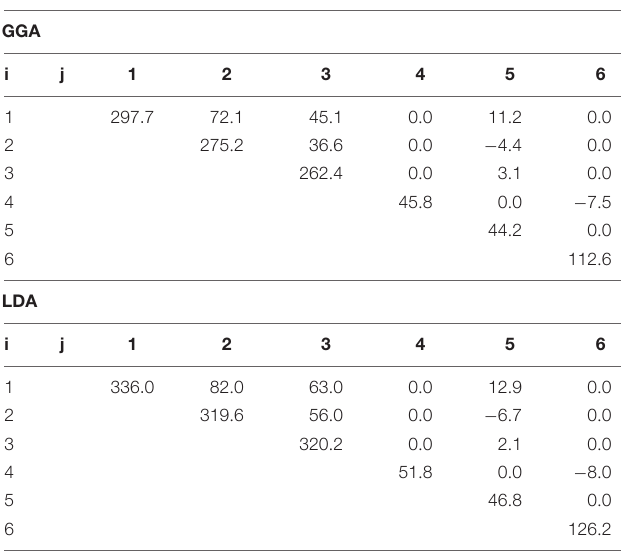
TABLE 2 | Elastic stiffness tensor ( C ij in GPa) of single crystal chloritoid using the GGA method ( P = 0 GPa, density = 3.10 g/cm 3 ) and the LDA method ( P = 0 GPa, density = 3.30 g/cm 3 ).